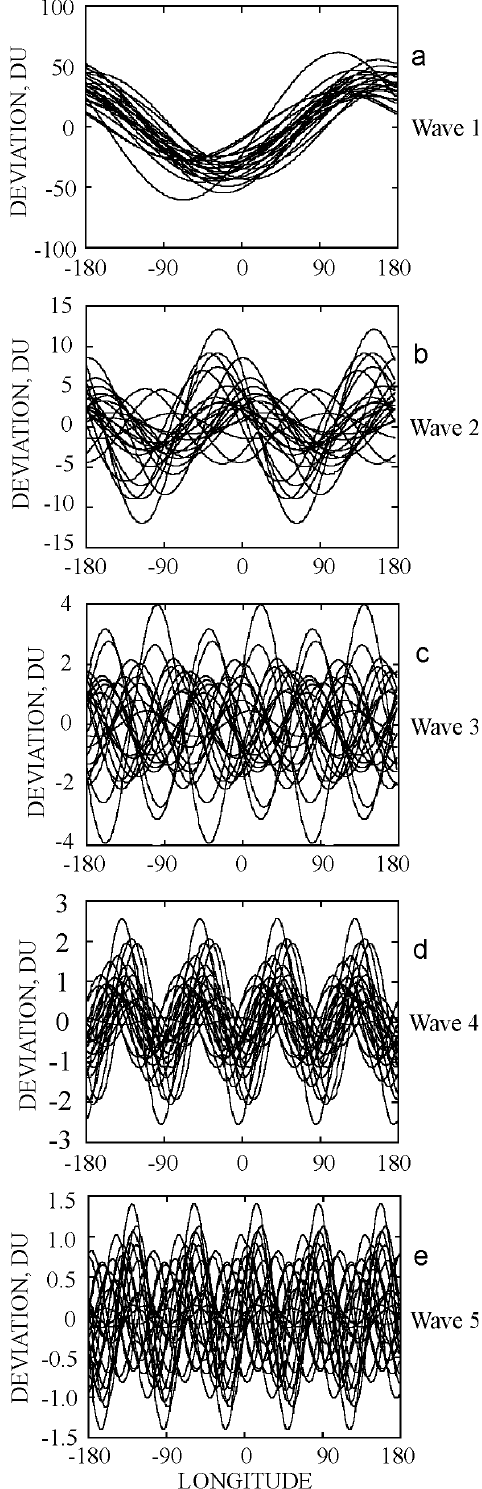
Fig. 7. Interannual changes of the stationary component of the wave numbers 1–5 (a–e) . The August-December averaging of the daily deviation from the zonal mean at 65 ◦ S was used. The period of 1979–2003 is presented.